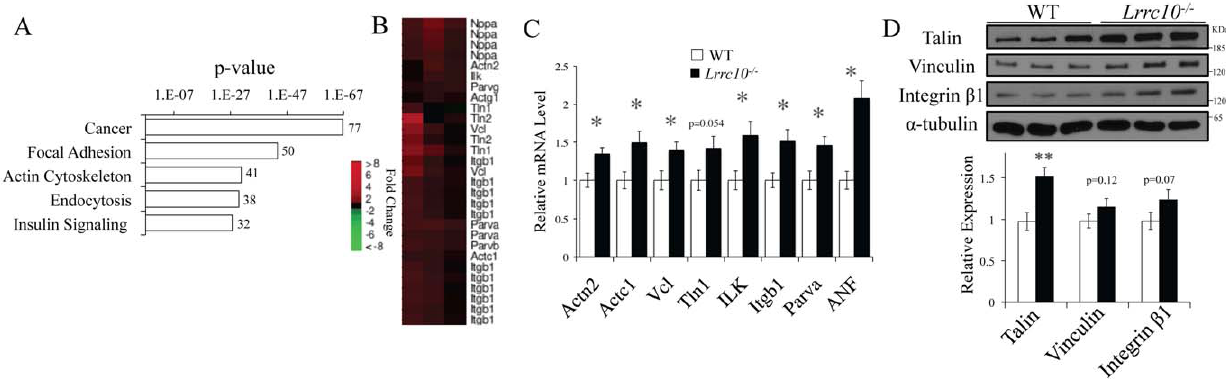
Figure 4. Gene expression profiling of embryonic Lrrc10 2 / 2 hearts. Microarray analysis was performed on WT and Lrrc10 2 / 2 hearts at E15.5 to identify dysregulated pathways in the absence of Lrrc10 . (A) Pathway analysis on genes upregulated 1.2-fold or greater (p , 0.05, signal $ 20) at E15.5. Shown are the five most significantly upregulated KEGG pathways in Lrrc10 2 / 2 hearts using DAVID. The number at the end of the histograms represents the number of upregulated genes in the KEGG pathway. (B) Heat maps from expression profiling and (C) qRT-PCR analyses demonstrate upregulation of actin cytoskeloton transcripts in embryonic Lrrc10 2 / 2 hearts (n=5–10). (D) Western blotting analysis of cytoskeletal protein expression in E15.5 hearts (n=4–5). Actn2 , actinin alpha 2; Actc1, actin alpha, cardiac muscle 1; Vcl , vinculin; Tln1 , talin 1; ILK , integrin-linked kinase; Itgb1 , integrin b 1; Parva , parvin alpha; E ; embryonic day.